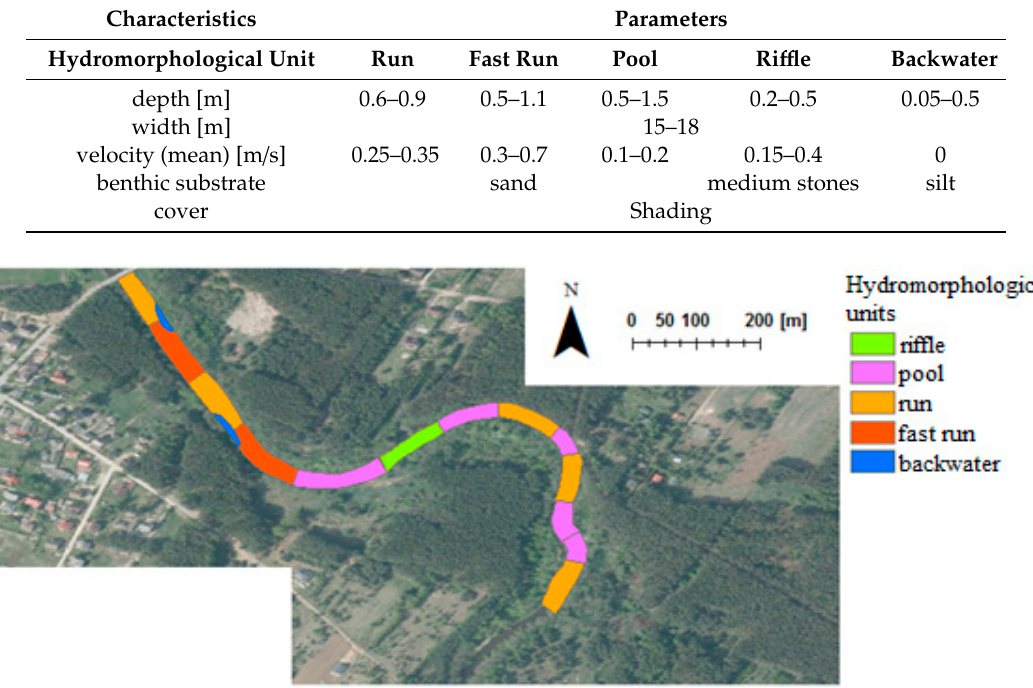
Figure 4. Hydromorphological units obtained after simulating river restoration of the analyzed section of the Swider River.